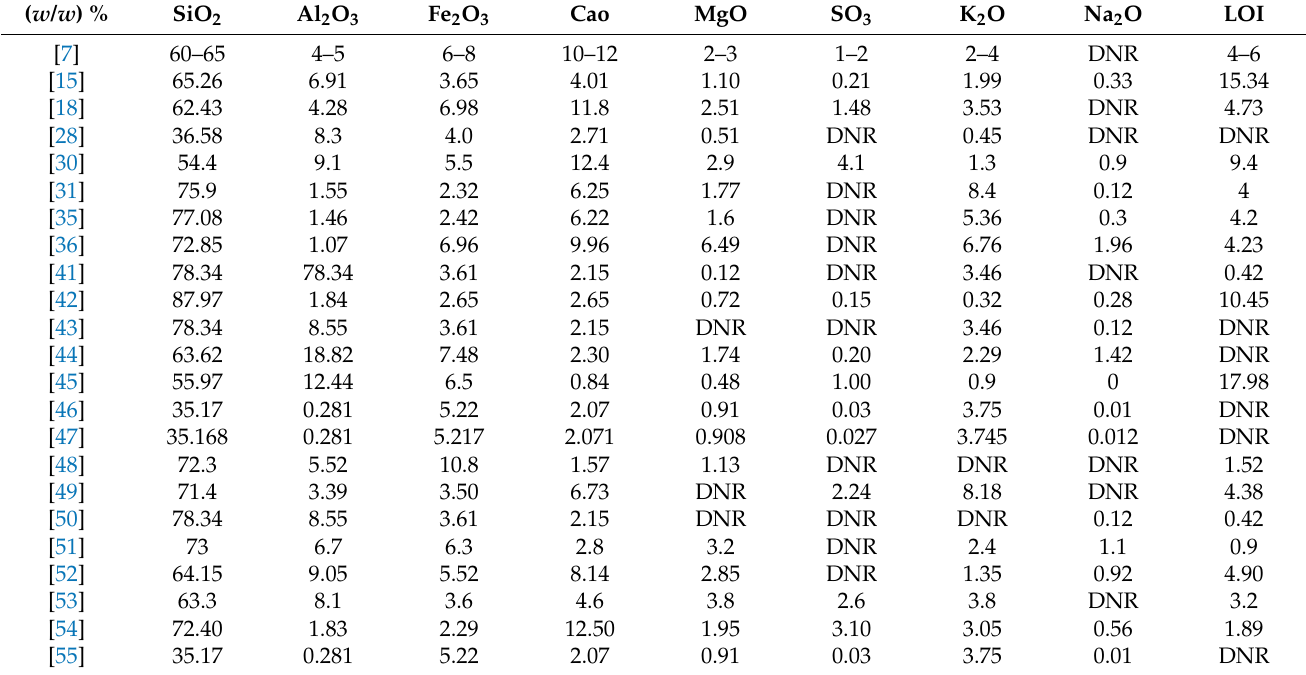
Table 2. Chemical composition of